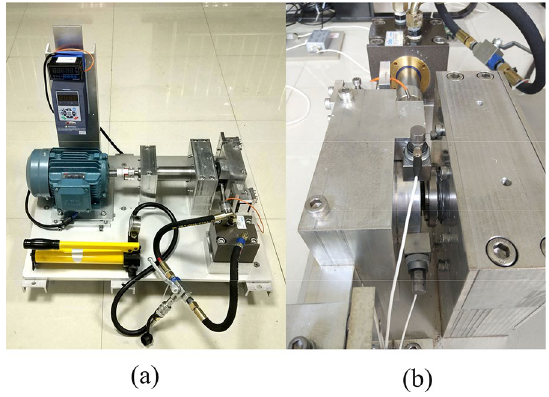
Figure 9 a Testbed of rolling element bearings and b accelerometer position